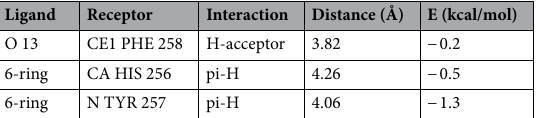
Table 9. Chemical interactions of compound 6e with amino residues of 2VF5.